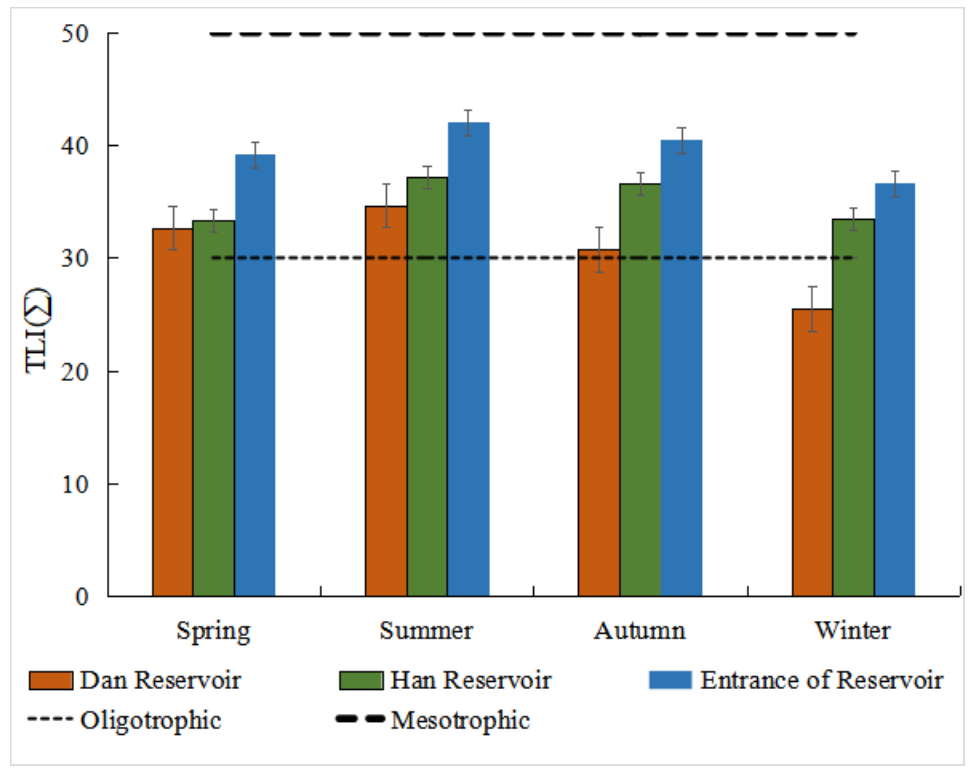
Figure 5. Spatio-temporal characteristics of the integrated trophic state index in the Danjiangkou Reservoir.